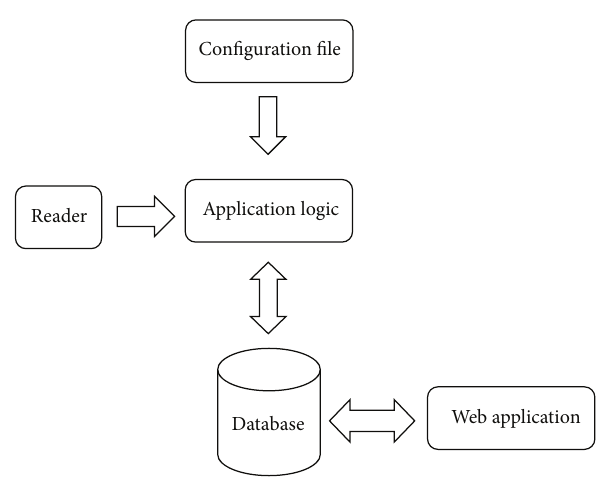
Figure 3: The system